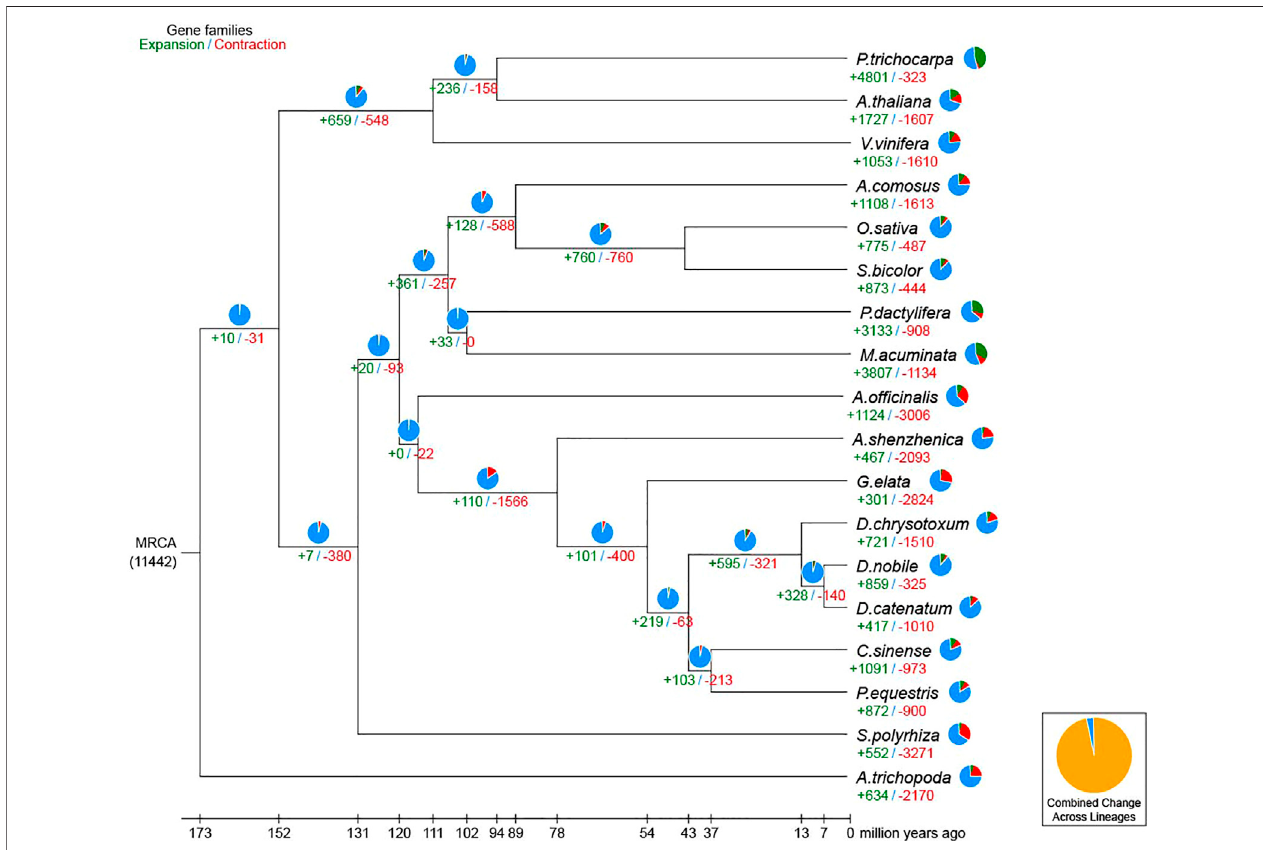
FIGURE 5 | Expansion and contraction of gene families. The green and red numbers are the numbers of expanded and contracted gene families, respectively.